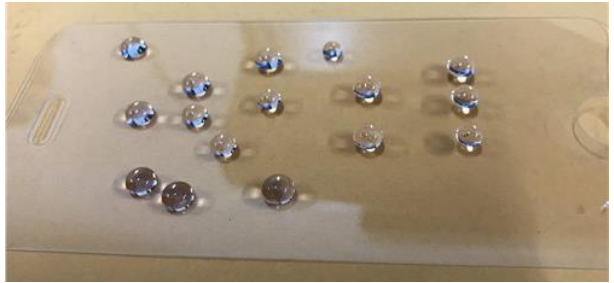
Figure 9. Hydrophobicity of FSi@SiO 2 coating on mobile phone screen.